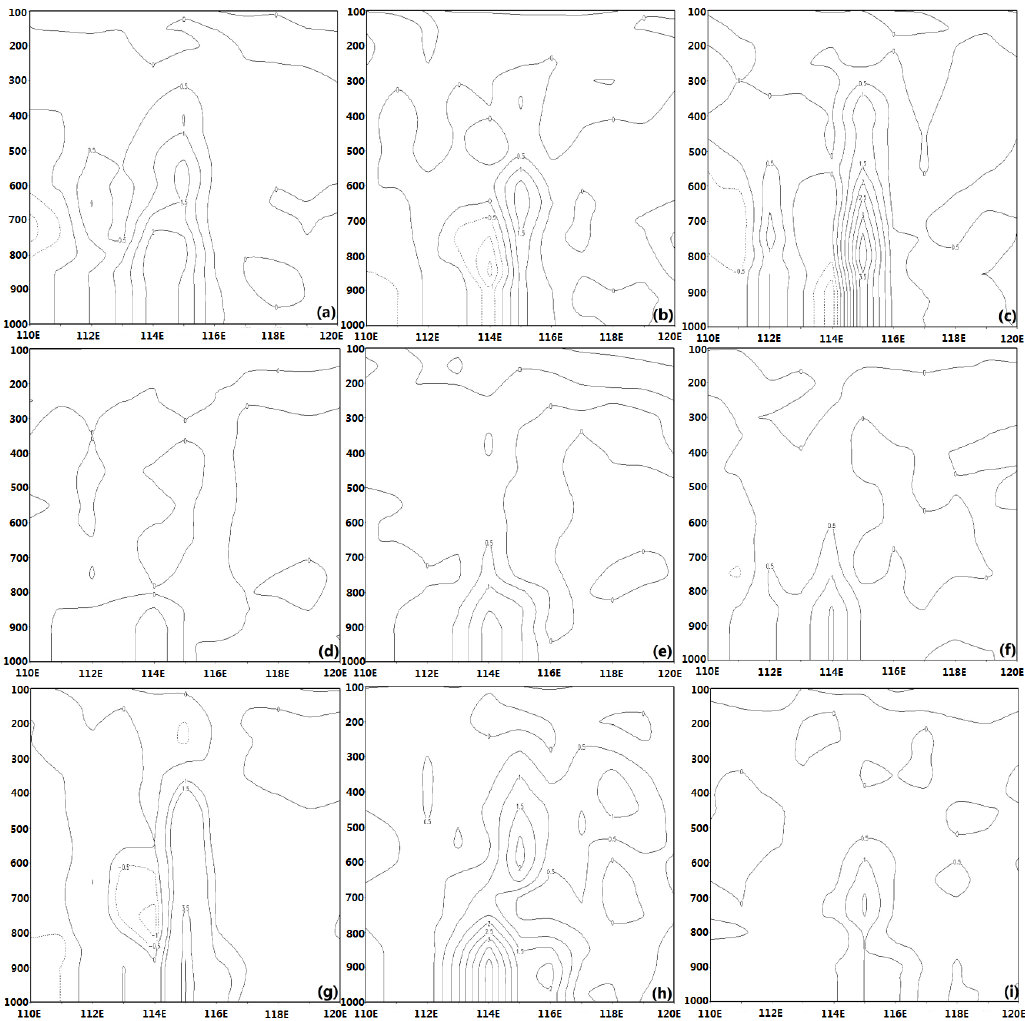
Figure 11. Cross-section of vertical velocity along the latitude of 40°N at 08:00 ( a – c ) on 16–18 August; 14:00 ( d – f ) on 26–28 August; and 08:00 ( g – i ) on 11–13 September in the Beijing area.